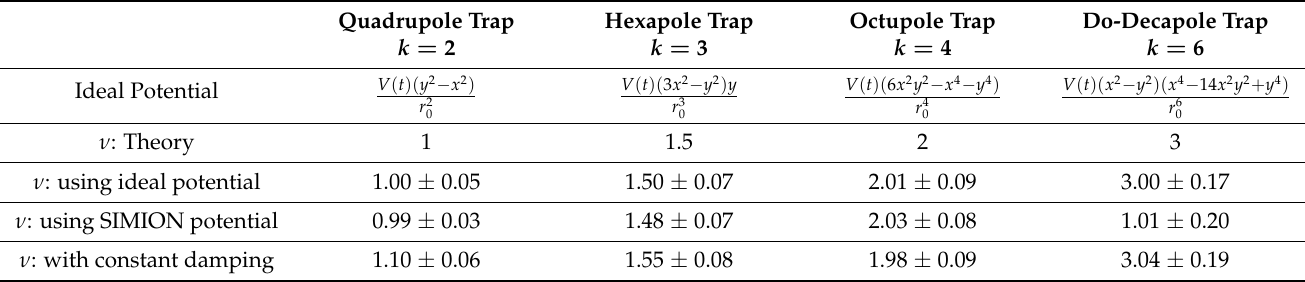
Table 1. Virial analysis of 2 k -pole traps in normal operation. Results for the coefficient ν from simulated trajectories using various appropriate potentials are shown, which illustrate the compliance with Equation (8). The average values were computed over several macromotion cycles and the standard deviation is shown as the